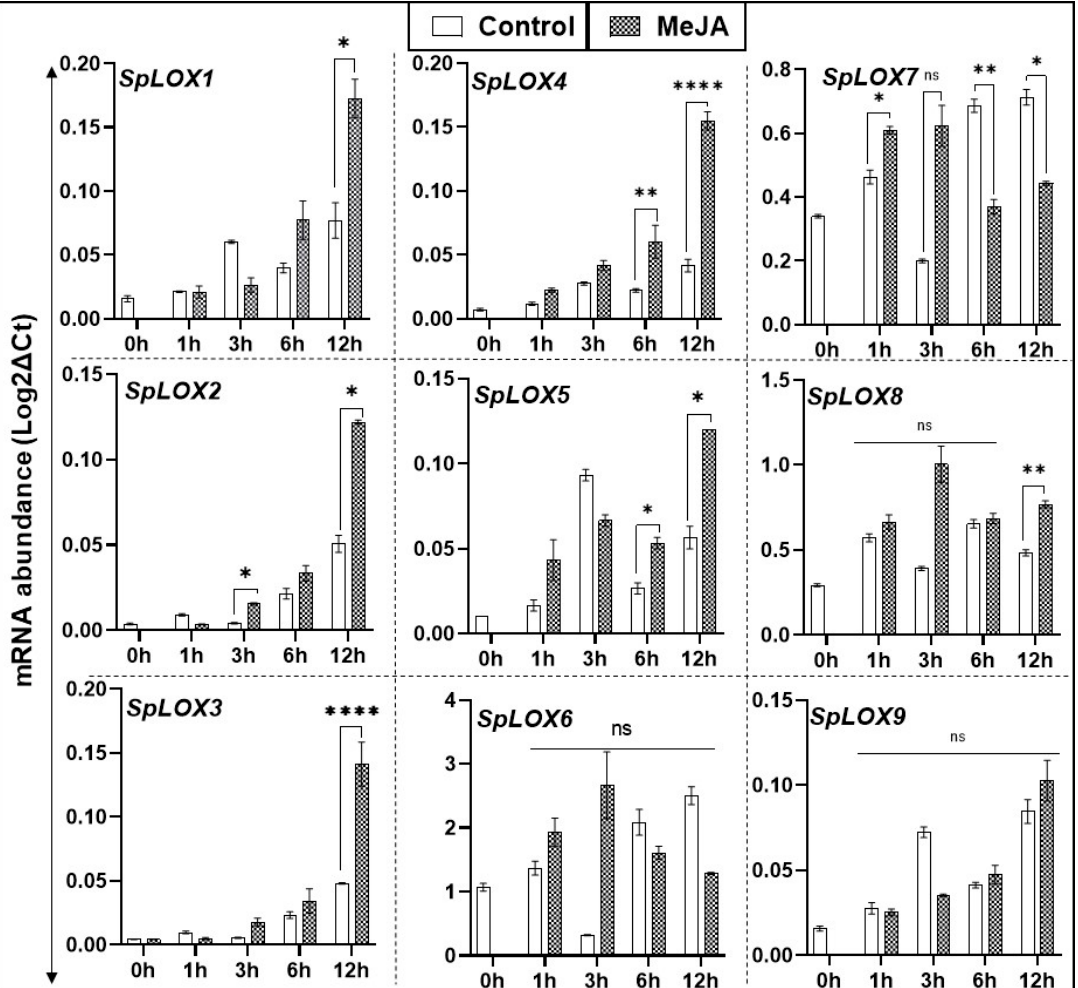
Figure 7. Methyl jasmonate (MeJA) induced feed-back regulation of Spirodela LOX gene family. MeJA (10 μ M) was added to 14-day-old S. polyrhiza 7498 cultures, as previously described [35]. Samples were collected at 0, 1, 3, 6, and 12 h after treatment. Gene expression data were analyzed in treated and untreated fronds by qRT-PCR. Statistical significance between treatment data points was assessed with respect to control for each time point and categorized as * p < 0.05, ** p < 0.01, and **** p < 0.0001 using graph pad (version 8.0); ns: not significant.